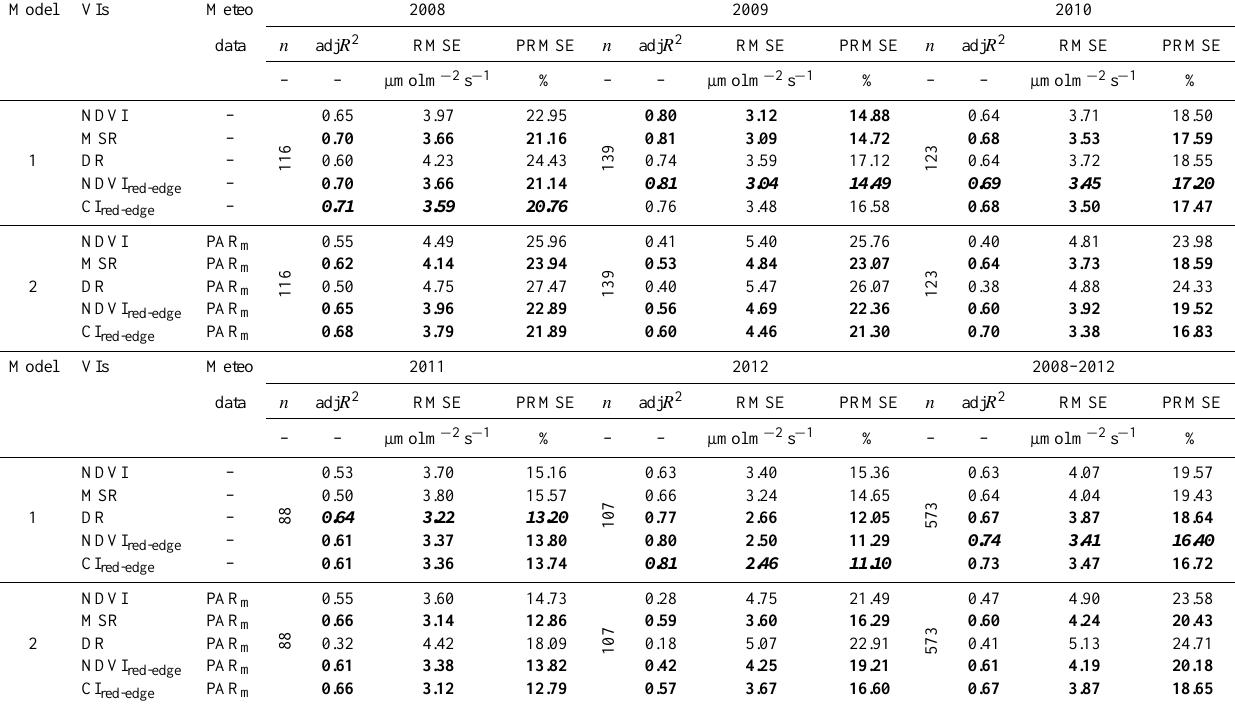
Table 4. Summary of the statistics ( n – number of observations, adj R 2 – adjusted coefficient of determination, RMSE – root mean square error, PRMSE – percentage root mean square error) of the two linear regression models tested in this study both annually and considering all of the 5 observation years together. The three best-fitting models in each group are printed in bold. The best performing model is additionally highlighted in italic. All the regressions were statistically significant ( p < 0 .